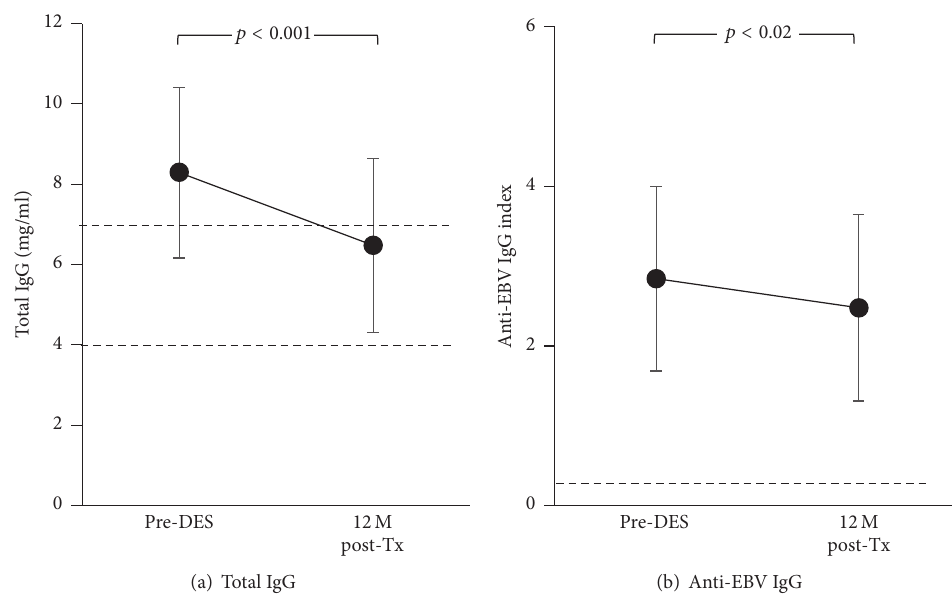
Figure 4: Total IgG (a) and anti-EBV IgG levels (b) before DES and at 12 months (M) after transplant (Tx) in 35 and 33 DES patients, respectively, who received DES with IVIg + rituximab followed by a kidney transplant with alemtuzumab induction. The results are expressed as mean and standard deviation. The dotted lines describe 7 and 4 mg/ml total IgG for the normal and severe hypogammaglobulinemia cutoff, respectively, in (a), and anti-EBV IgG index 0.25 for sero(+) cutoff level in